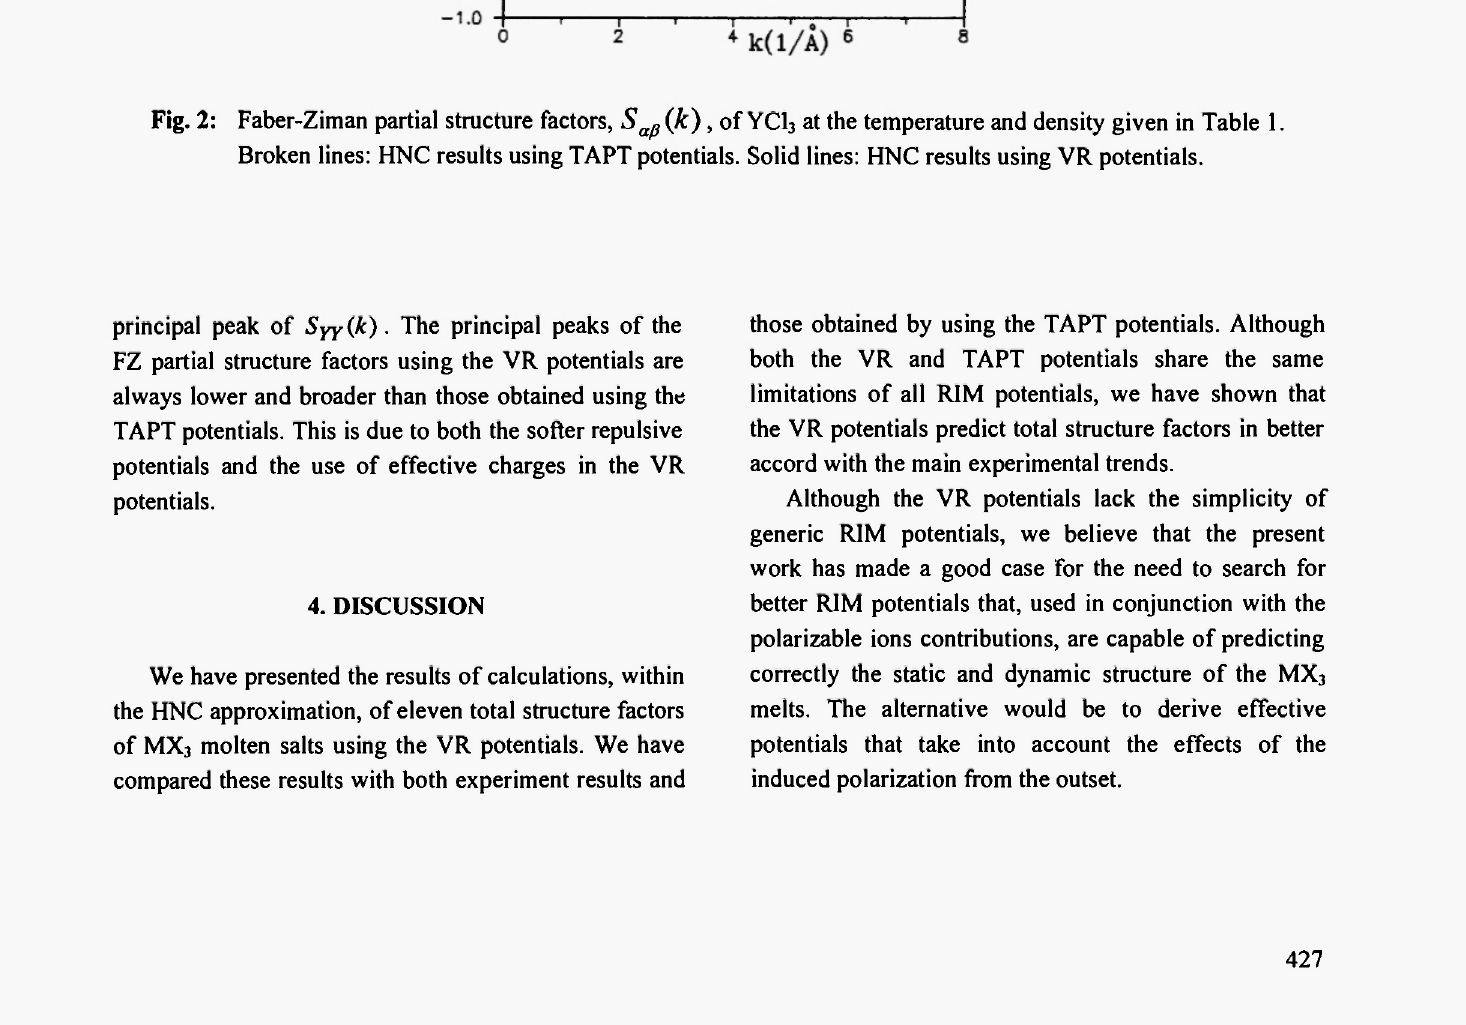
Fig. 2: Faber-Ziman partial structure factors, S aß (k), of YC1 3 at the temperature and density given in Table 1 . Broken lines: HNC results using TAPT potentials. Solid lines: HNC results using VR